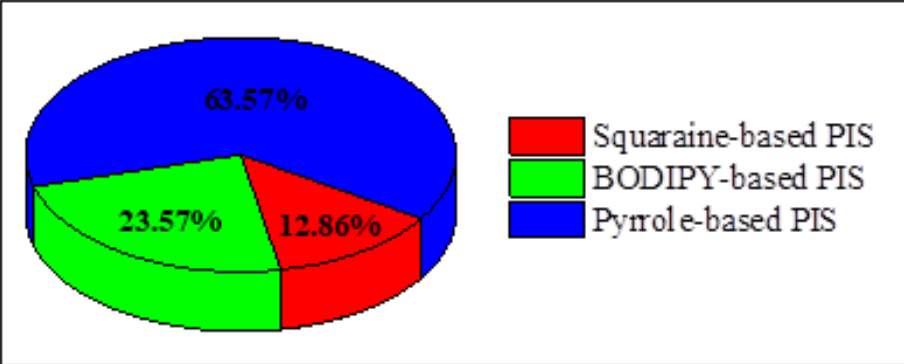
Figure 23. Diagram illustrating the relationship of the number of research papers in 2012–2022 on dyeing photoinitiating systems depending on the type of used photosensitizer. Based on data from Science Direct. Keywords: squaraine AND photoinitiator, BODIPY AND photoinitiator, pyrrole AND photoinitiator. Accessed on 13 February 2023.